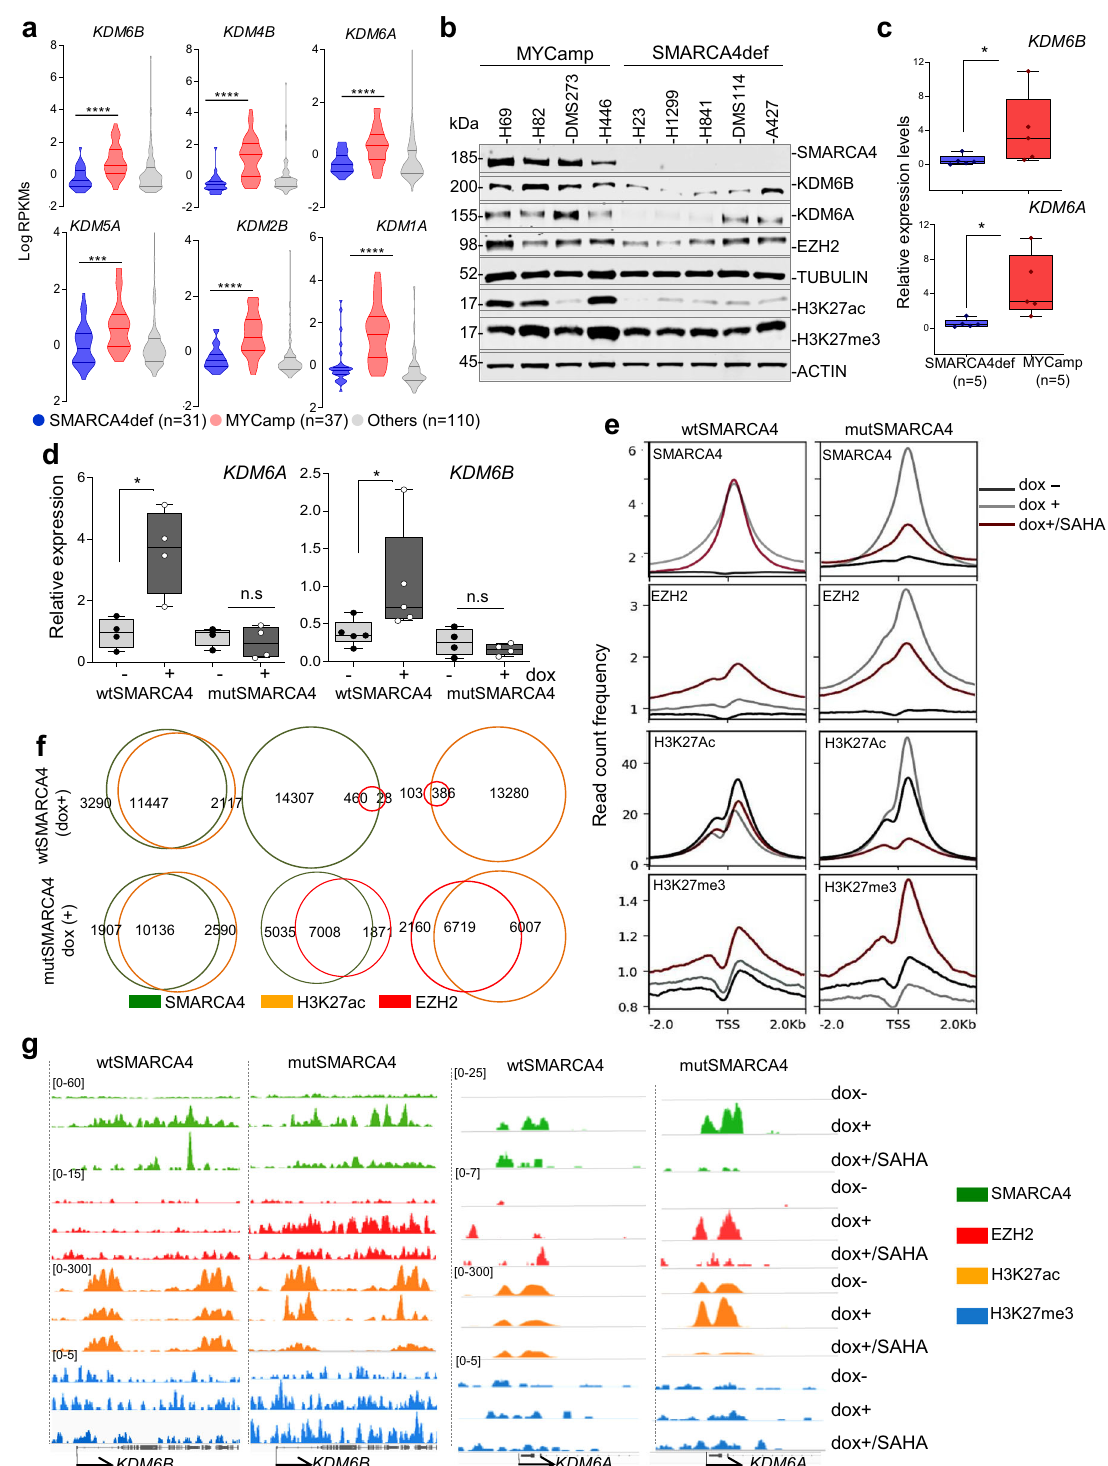
overexpressed mutant protein has a dominant negative effect. H3K27ac marks were present in at least 80% of the promoters bound by SMARCA4 and some also showed EZH2 occupancy (Fig. 2f; Supplementary Fig. 6a). The increase in EZH2 binding following expression of the SMARCA4 mutant is consistent with previous fi ndings that ectopic expression of an SMARCA4- inactive protein allows the occupancy of PRC1 and PRC2 in CpG island promoters throughout the genome 26